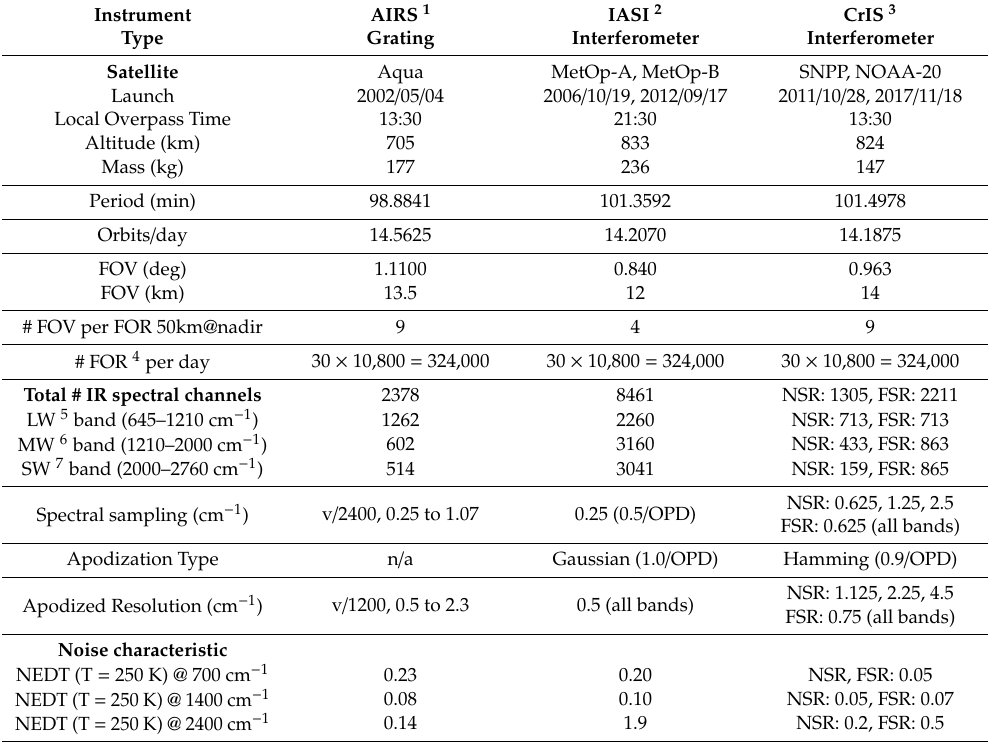
Table 1. Overview of the three modern-era hyperspectral infrared (IR) instruments on low-Earth orbiting satellite platforms. CrIS on SNPP was at first transmitted at nominal spectral resolution (NSR) but later switched to full spectral resolution (FSR) so we list statistics for both. These instruments measure the top of atmosphere radiance with spatial footprints known as (FOV) and CLIMCAPS retrieves soundings from a cluster of FOVs knowns as the Field of Regard (FOR). Instrument noise is given in brightness temperature units as the noise equivalent delta temperature (NEDT) for a scene at